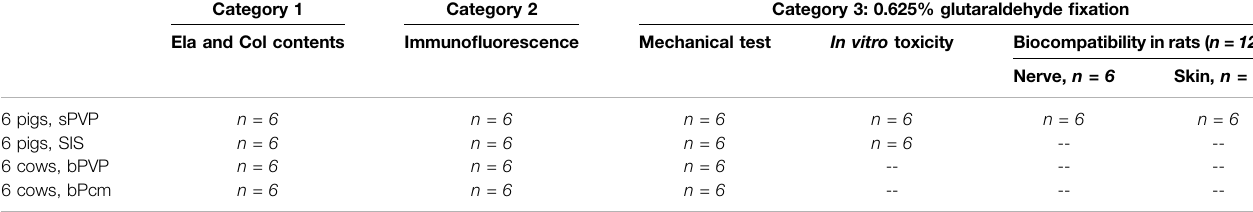
TABLE 1 | Distribution of various tissues for mechanical and biological